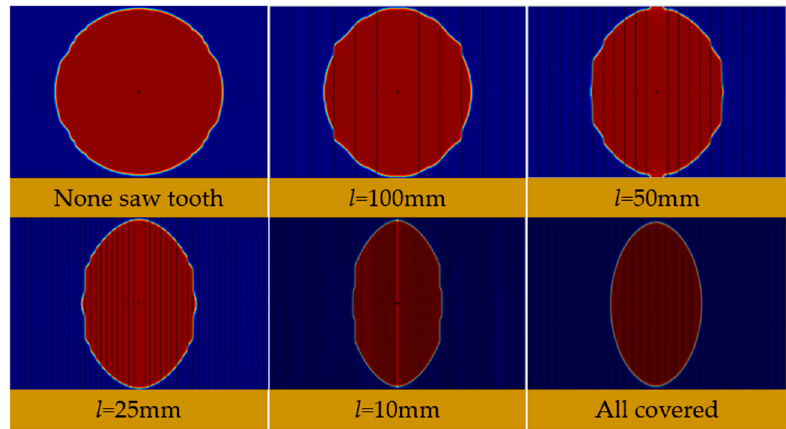
Figure 20. Comparison of grouting diffusion range under different conditions.